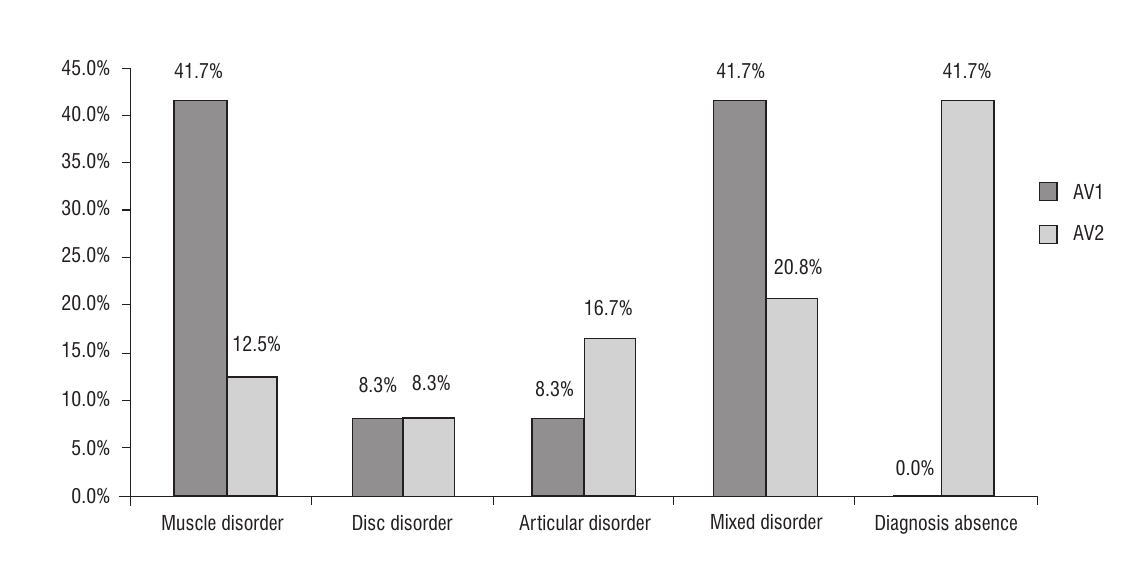
Table 1 - Mean, standard deviation and decrease percentage of Temporomandibular Indices and muscular, articular and functional sub-indices in the initial (AV1) and immediately after treatment assessments (AV2) Indices (n = 24) Measurements AV1 AV2 % Decrease mean (SD) 0.53 (0.13) 0.38 (0.12) Temporomandibular Index 28.3% P 0.000 * Muscular Sub-Index mean (SD) 0.38 (0.19) 0.29 (0.15) 23.68% P 0.035 * Articular Sub-Index mean (SD) 0.49 (0.29) 0.26 (0.22) 46.94% P 0.001 * Functional Sub-Index mean (SD) 0.73 (0.18) 0.002